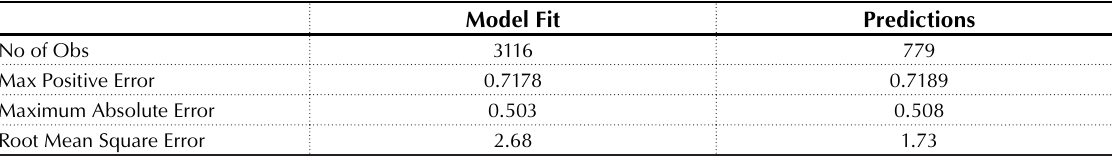
Table 8. Comparative intercepts